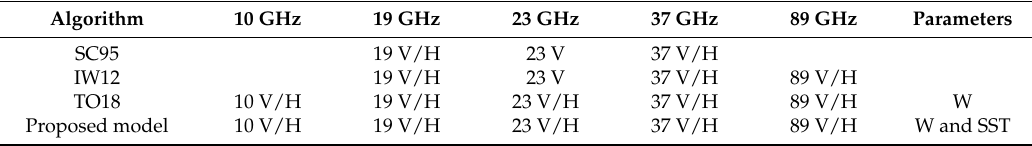
Table 3. Channels and meteorological parameters for each algorithm.